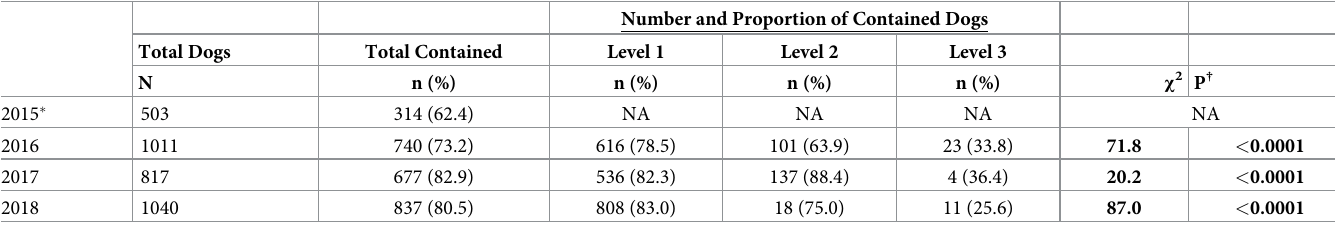
Bold indicates statistical significance.